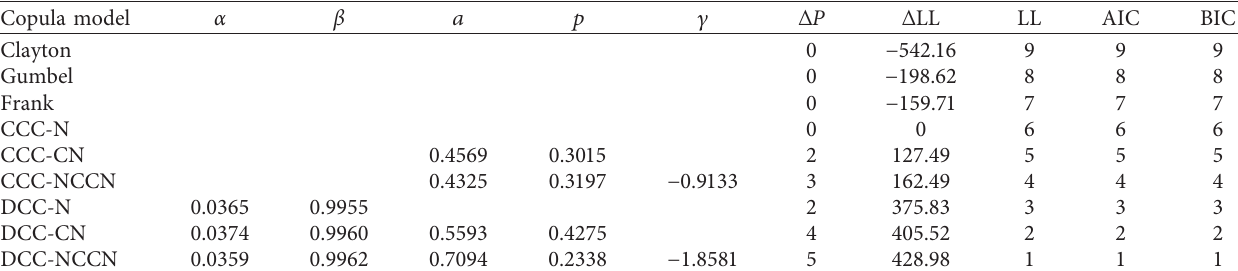
Table 7: Fitting results of bivariate copula models